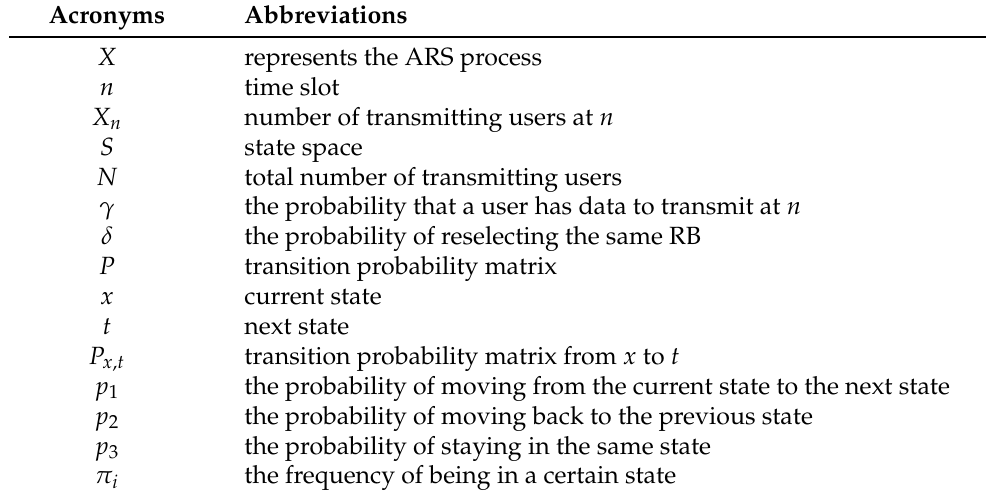
Table 1. List of